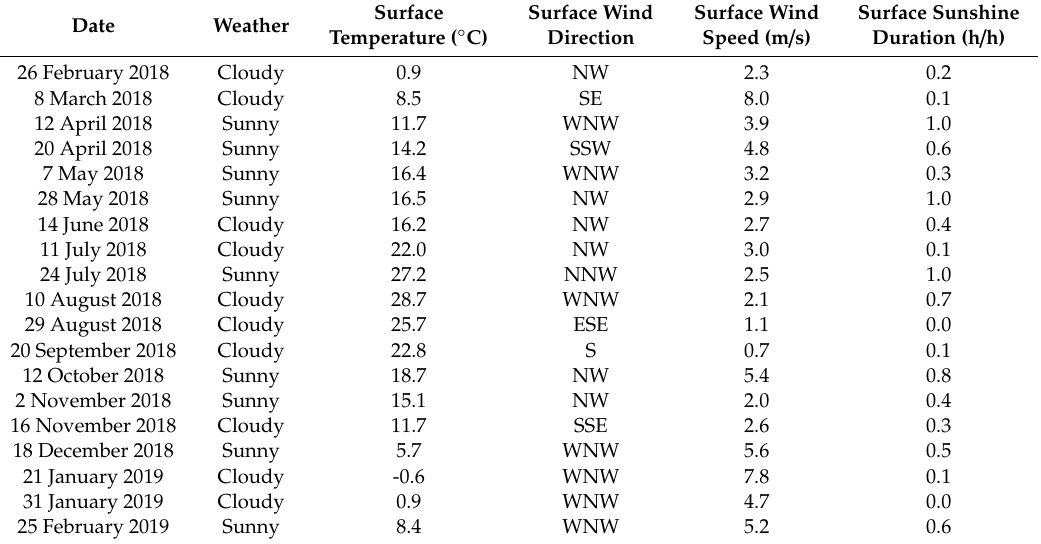
Table 3. Surface temperature at 1.5 m altitude, wind direction and speed at 10 m altitude, and sunshine duration (see text for details) based on hourly data at Ogata on each survey date from February 2018